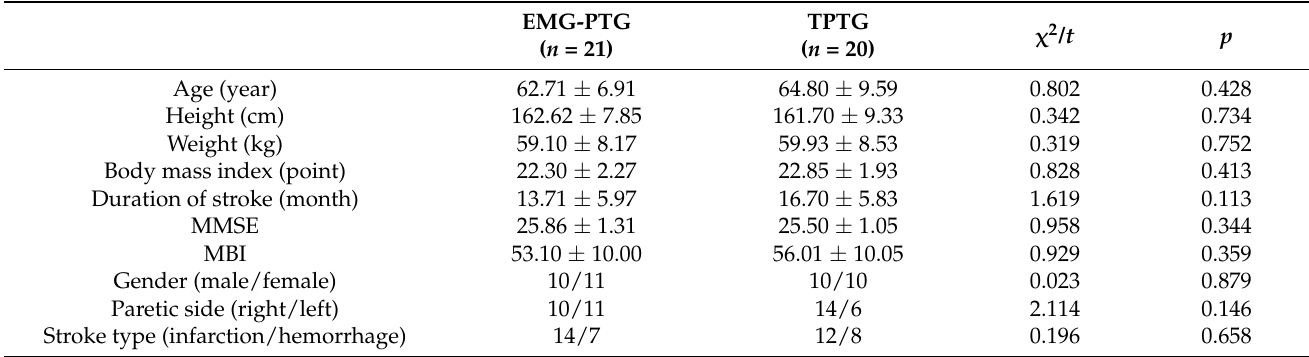
Table 1. General characteristics of the subjects.